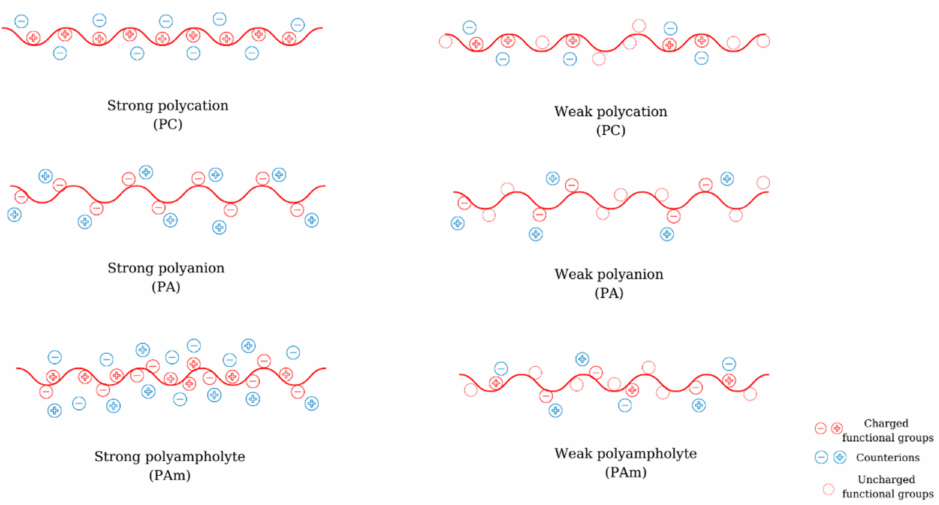
Figure 1. Classification of polyelectrolytes according to the nature of the functional groups and the ionic